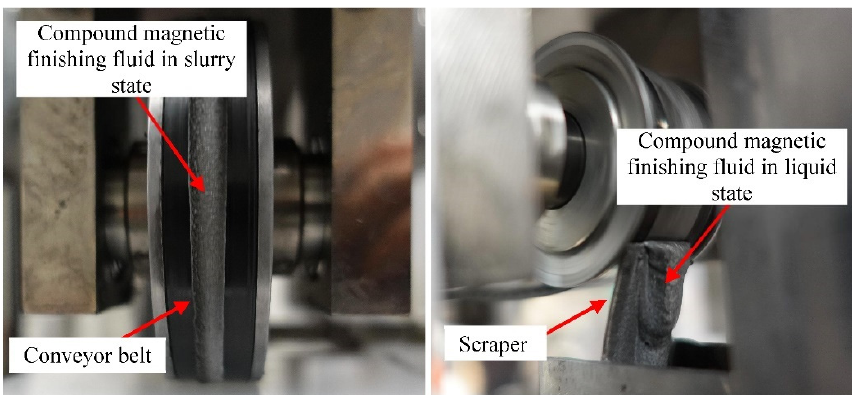
Figure 5. The status of the compound magnetic finishing fluid in the different